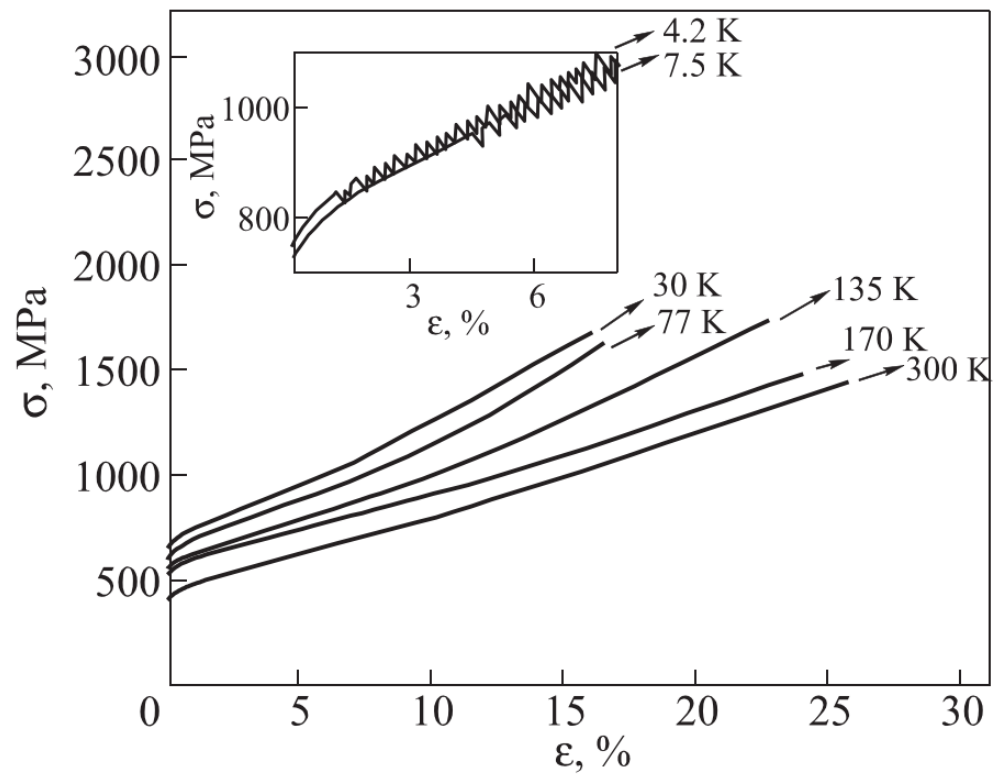
Figure 34. The stress–strain curves for the Ag 0.5 CoCrCuFeNi HEA that was undergoing tension testing at temperatures ranging from 4.2 to 300 K, at a strain rate of 4 × 10 − 4 s − 1 . The inset displays a close-up of the serrated flow that occurred in the specimens tested at 4.2 and 7.5 K. (Reproduced from Reference [296] with permission).